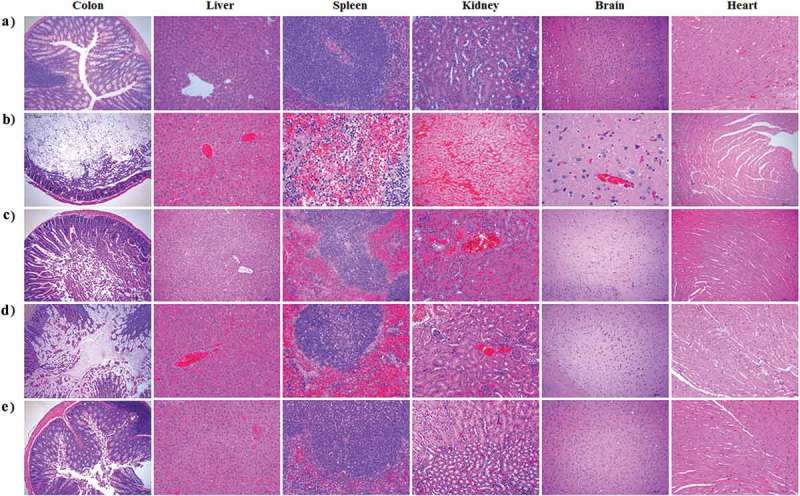
Histopathological examination of immunized mice after a challenge with the α-toxin. No histopathological changes were observed in the heart, liver, spleen, kidneys, colon, and brain of mice in the normal control group (a). Histopathological changes after the challenge were noticed in the tissues of mice orally vaccinated with PBS (b) or pPG/L. casei 393 (c). In the commercial vaccine group (d), histopathological changes were observed in the liver, kidneys, and colon of the mice, particularly in the colon after the challenge, whereas little or no histopathological changes were observed in the tissues of mice orally immunized with pPG-α/L. casei 393 (e). Tissue sections were stained with hematoxylin and eosin and photographed at 40× magnification.